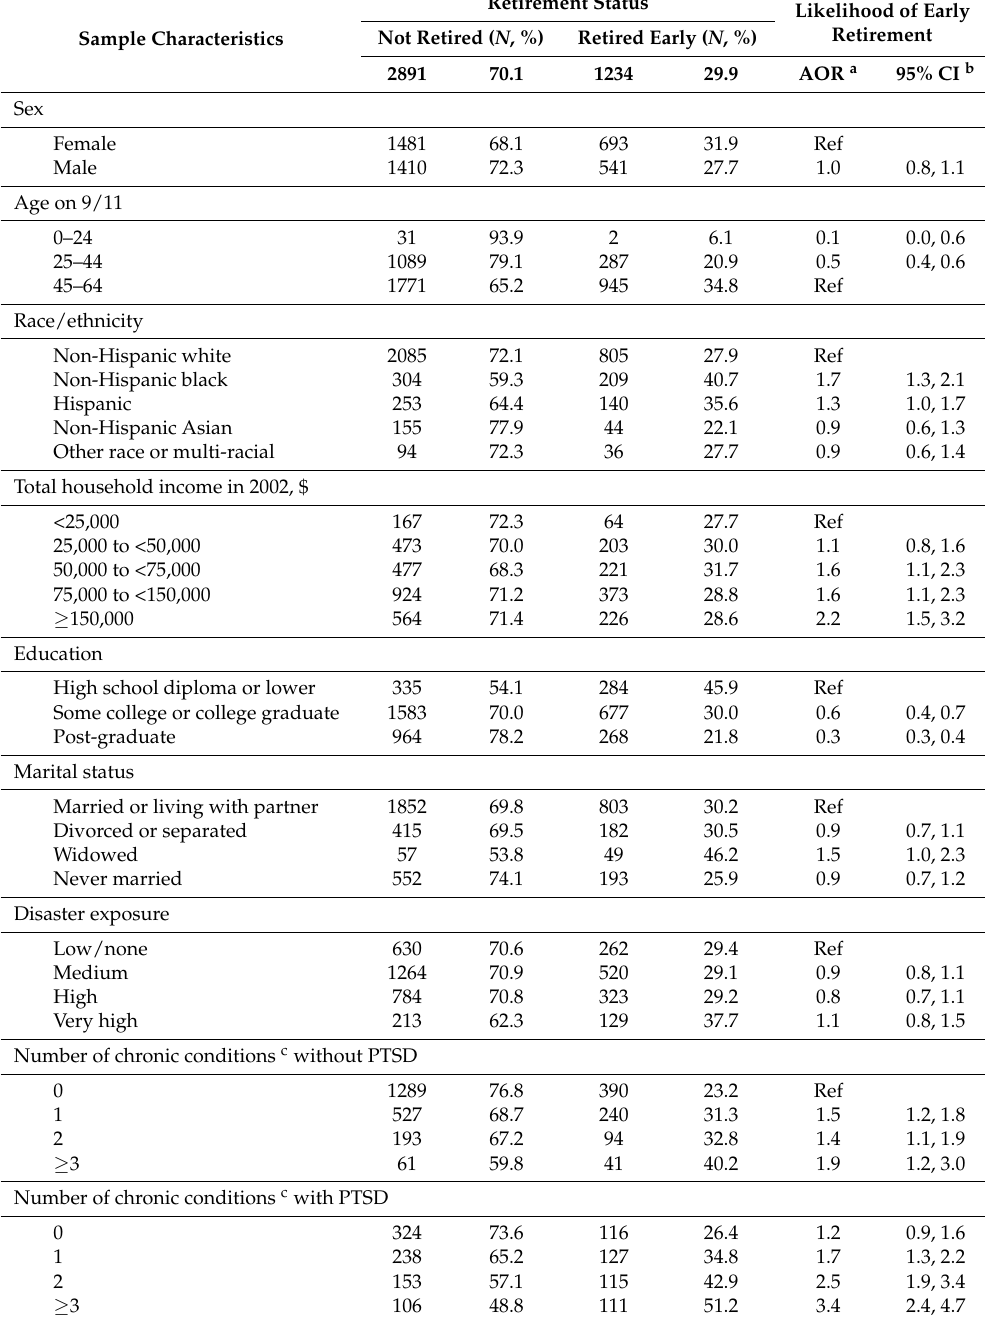
a AOR: Adjusted odds ratio and was adjusted for all factors listed in this table. b 95% CI: 95% confidence interval. c Chronic physical health conditions include asthma, heart diseases, stroke, lung diseases, diabetes, gastroesophageal reflux disease (GERD), and autoimmune